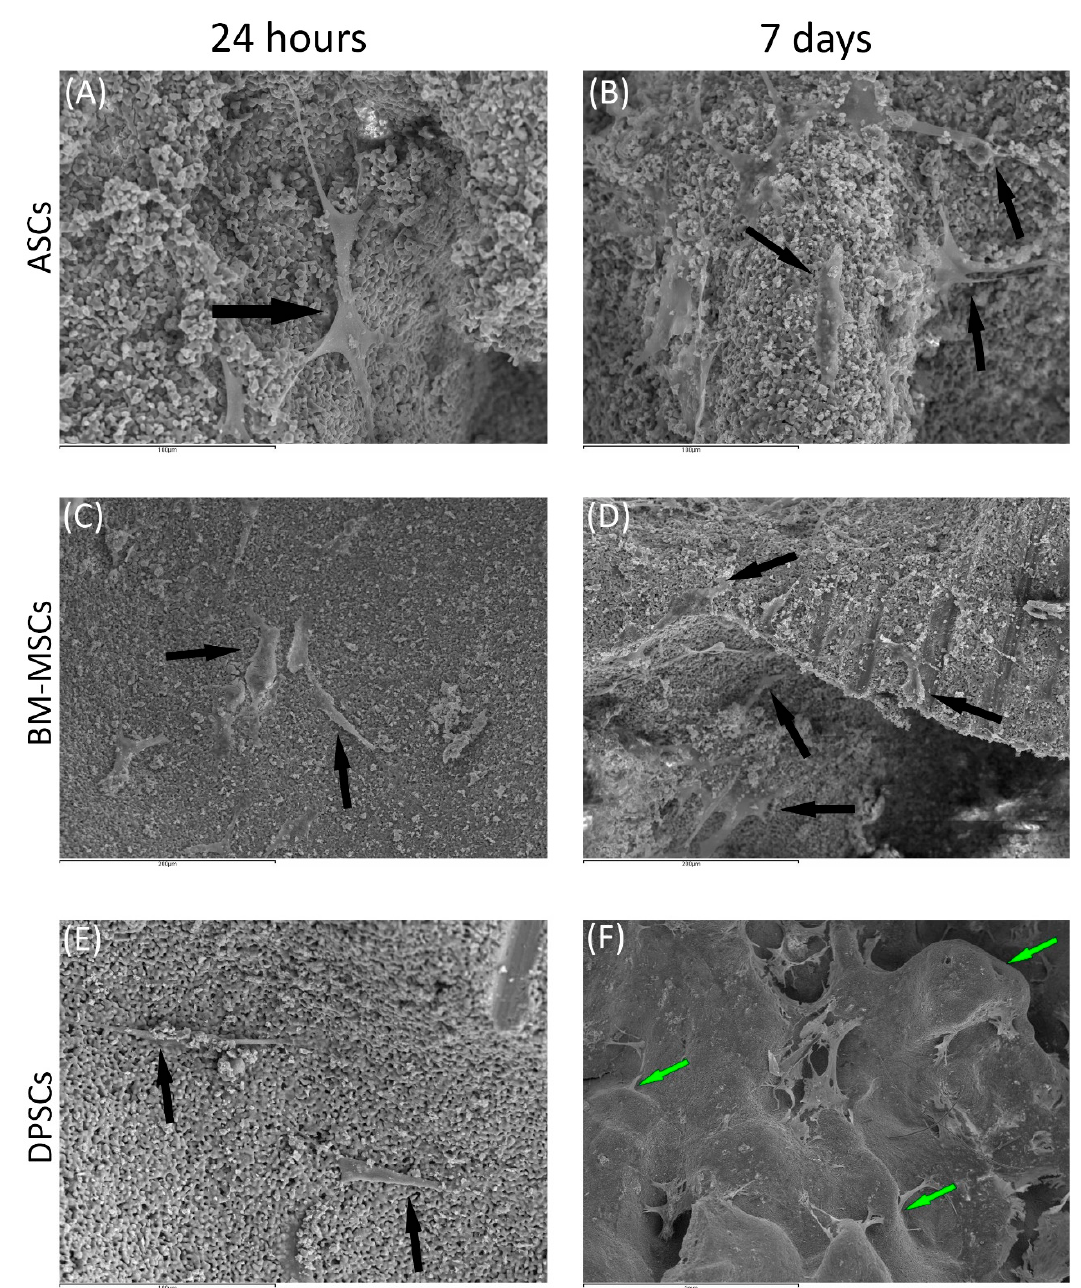
Figure 4. The behaviour of MSCs seeded on HA scaffold at different time points: ( A ) ASCs on HA scaffold after 24 h (scale bar: 100 μ m); ( B ) ASCs forming cell layer on HA scaffold after 7 days (scale bar: 100 μ m); ( C ) BM-MSCs on HA scaffold after 24 h (scale bar: 200 μ m); ( D ) BM-MSCs forming cell layer on HA scaffold after 7 days (scale bar: 200 μ m); ( E ) DPSCs on HA scaffold at 24 h (scale bar: 100 μ m); and ( F ) DPSCs forming cell layer on HA scaffold after 7 days (scale bar: 1 mm). Black arrows indicate unique cells. Green arrows indicate cell layers.